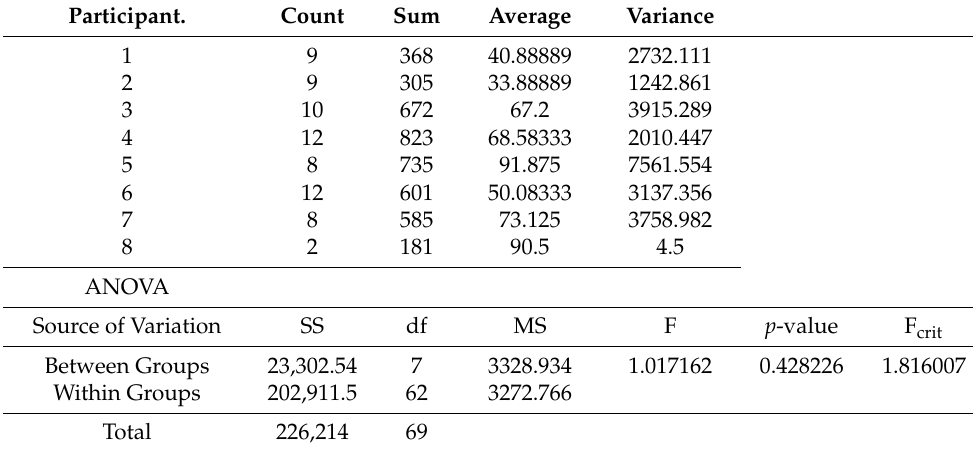
Table 3. Results from the ANOVA on users’ times with alpha = 0.1. Participant.